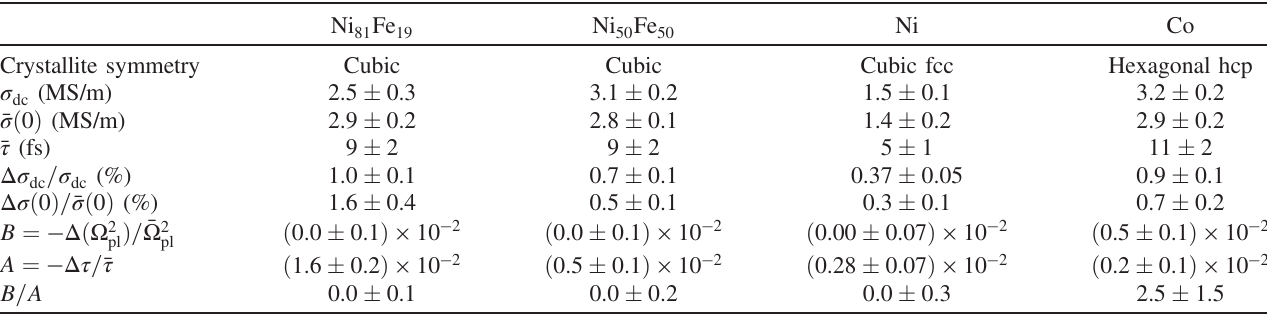
TABLE I. Sample properties and fit parameters. All films are polycrystalline. The parameters ¯ σ ð ω ¼ 0 Þ , ¯ τ , Δ σ ð 0 Þ = ¯ σ ð 0 Þ , A , and B were obtained by fitting the Drude model for conductivity [Eq. (2)] and AMR contrast [Eq. (3)] to the data shown in Fig. 3. The ratio B=A of extrinsic and intrinsic contributions to the AMR reveals a different AMR regime in Co as compared to the other materials. The parameters A and B were obtained by fitting over the whole frequency range 0 . 2 – 28 THz and over the range 8 – 28 THz, both yielding consistent values (see Supplemental Material [41]). The uncertainties arise from the precision and accuracy of our measurements as detailed in Appendix